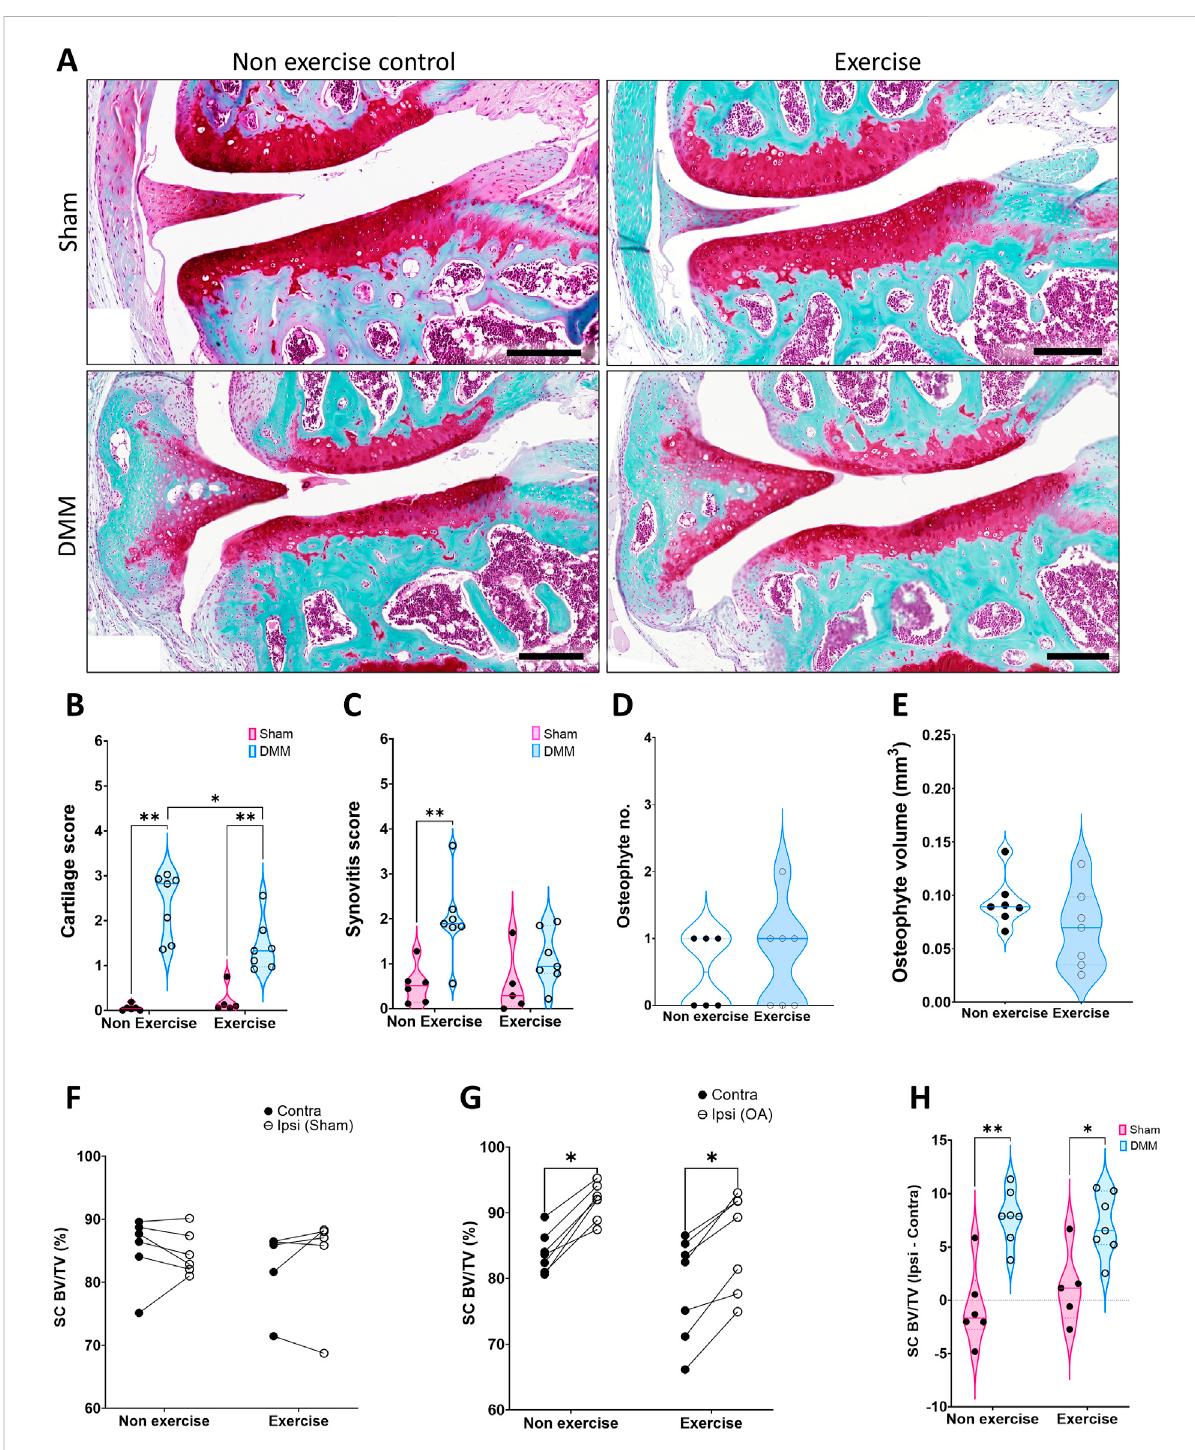
FIGURE 3 Disease parameters on mice 8 weeks after induction of OA. (A) Representative images of the joint at 8 weeks, stained with SafraninO for cartilage and Fast Green for bone. (B) Cartilage score. (C) Synovitis score. (D) Osteophyte number. (E) Osteophyte volume. (F) Comparison ofmedial subchondral bone compartment density (% BV/TV) between the operated ipsilateral (Ipsi) and control contralateral (Contra) legs in (F) sham and (G) DMM groups. (H) Changein tibial subchondral bone sclerosis(Ipsi – Contra). Comparison between exercise and non-exercise groups was done with a 2-way ANOVA with Bonferroni correction unless data was not normally distributed, in which case it was then compared by a Mann-Whitney test. Paired comparisons were conducted via a paired t-test. *p < 0.05, **p <